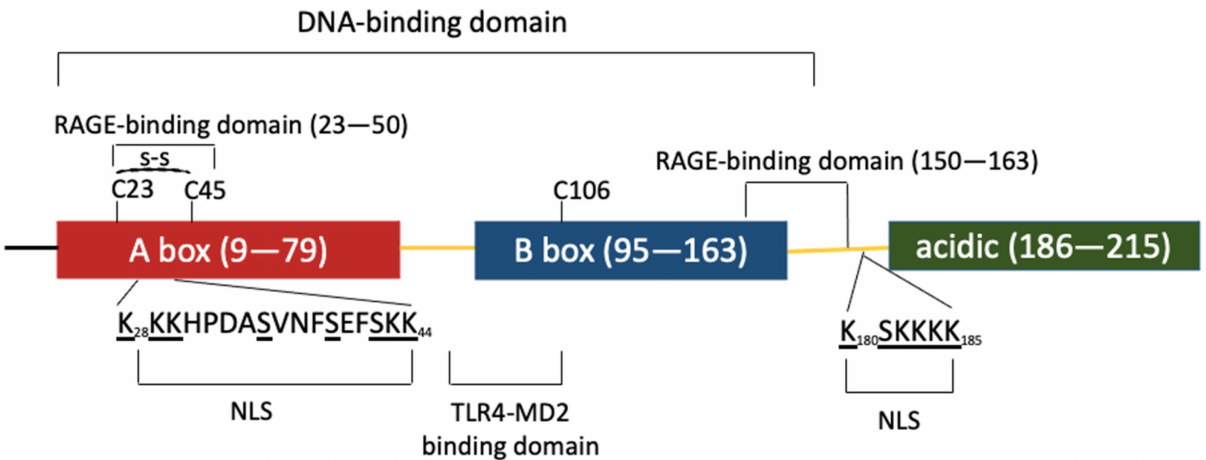
Figure 1. HMGB1 is composed of three domains represented by colored boxes. The A (red) and B (blue) boxes are involved in DNA binding. These DNA-binding domains are followed by an acidic C-terminal region (green). The three domains are separated by linker regions (yellow). Two nuclear localization signals (NLS1 and 2) are involved in HMGB1 nuclear import; one is located within box A and the other is positioned in the linker region before the acidic domain. The post-translationally modified amino acids within NLS1 and 2 are underlined. K and S residues are acetylated and phosphorylated, respectively. These post-translational modifications impair HMGB1 interaction with karyopherin α 1, favoring HMGB1 cytoplasmic accumulation and secretion. The domains involved in HMGB1 binding to different membrane receptors are also specified.